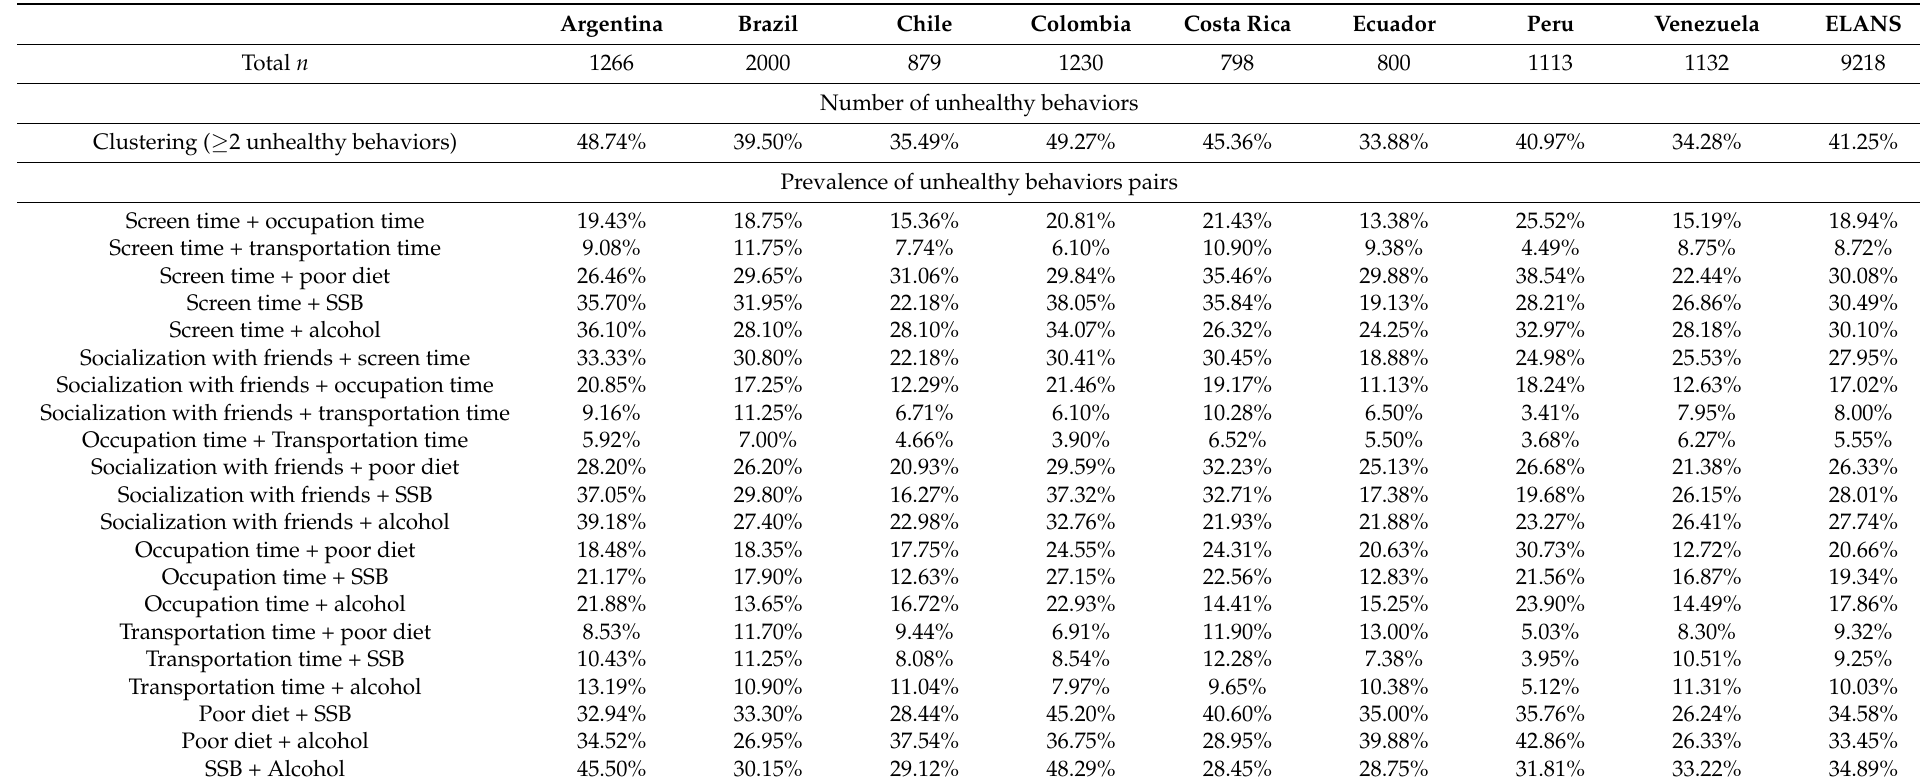
Table 2. Patterns of sedentary behaviors and dietary components among adolescents and adults. The Latin American Health and Nutrition Study (ELANS) ( n =